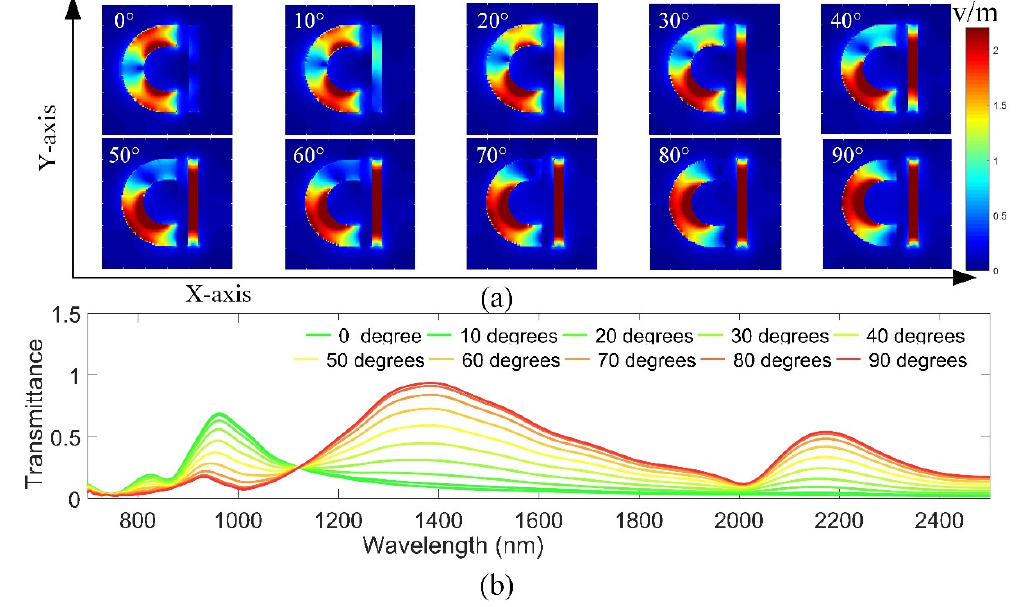
Figure 2. ( a ) Spatial distributions of the electric near field E with the different incident polarization angles θ on the plane of Z = 375 nm (detection plane), respectively. ( b ) Transmittance spectrum of hoof-shaped structure arrays with different θ with P x = P y = 600 nm.